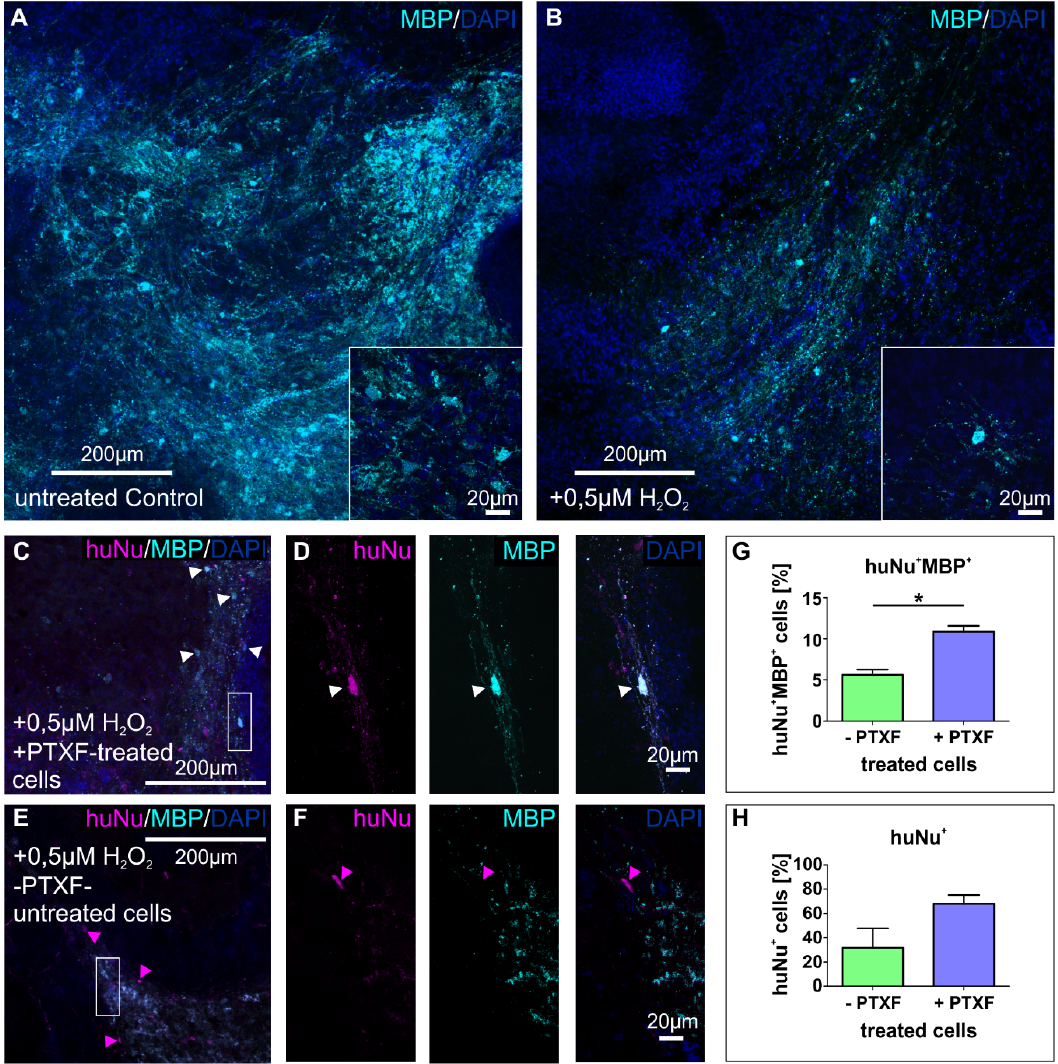
Figure 6. Immunocytochemical analyses of transplanted NCSC-derived NSCs or predi ff erentiated NCSC-derived NSCs into demyelinated mouse organotypic cerebellar slice cultures. ( A , B ) Immunostaining against MBP showing untreated control and 0.5 µ M H 2 O 2 treated cerebellar mouse slices. Confocal images show a clear decrease in MBP fluorescence at 0.5 µ M H 2 O 2 compared to control in a representative area. Insets show a central area of A and B respectively under higher magnification. Undi ff erentiated or predi ff erentiated NCSC-derived NSCs (treated with PTXF for 3 days, + PTXF) were transplanted into the slices and further cultivated for 2 weeks to determine their ability to di ff erentiate and produce myelin in this demyelination model. ( C ) Immunostaining against MBP and huNu showing a 0.5 µ M H 2 O 2 treated cerebellar mouse slice transplanted with predi ff erentiated NCSC-derived NSCs ( + PTXF-treated cells). White arrowheads indicate huNu + MBP + double positive cells, representing cells of human origin which express MBP, human oligodendrocytes. Inset shows a clear huNu + MBP + cell indicating its human origin. ( D ) huNu + MBP + cell from the inset in C, at higher magnification showing this cell from human origin expressed MBP at the protein level. ( E ) Immunostaining against MBP and huNu showing a 0.5 µ M H 2 O 2 treated cerebellar mouse slice transplanted with untreated NCSC-derived NSCs ( − PTXF-untreated cells). Magenta arrowheads indicate huNu + cells of human origin. Inset shows a huNu positive cell indicating its human origin. ( F ) Inset indicated in E, at higher magnification showing a huNu + MBP − NCSC-derived NSCs. ( G ) Quantification showing the percentage of huNu + MBP + double positive cells in H 2 O 2 -treated cerebellar mouse slices